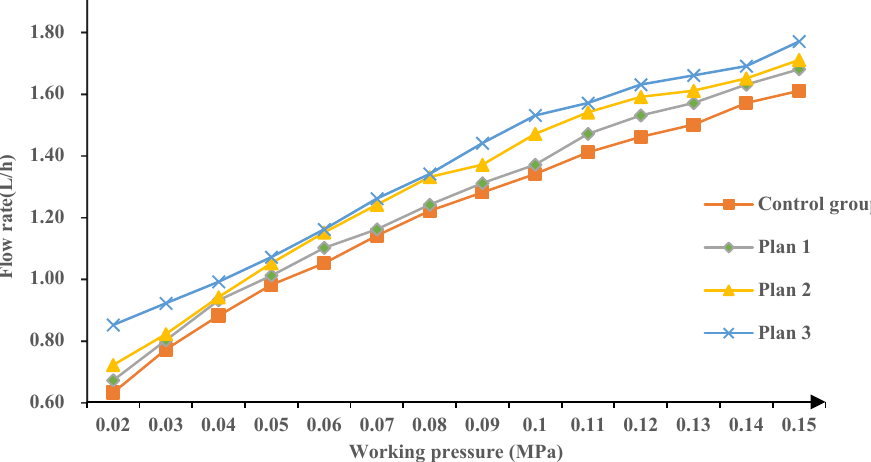
Figure 13. The variations of the hydraulic characteristic curves for different emitter optimization plans.